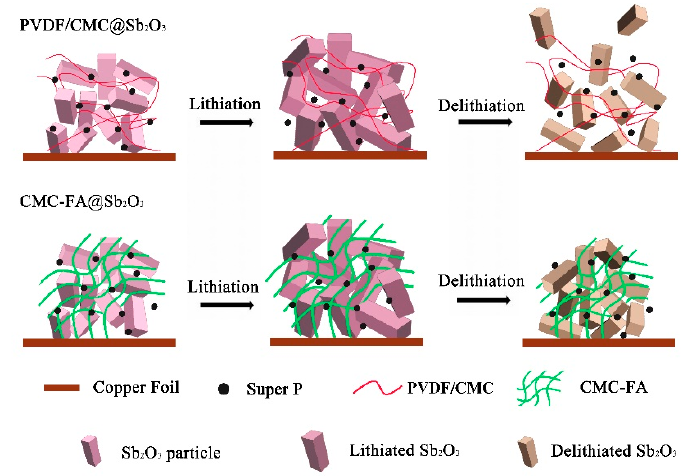
Figure 6. Schematic illustration of the proposed mechanism of cross-linked CMC-FA binder and PVDF / CMC binder in Sb 2 O 3 electrodes. Table 1. Comparison of the electrochemical performances of CMC-FA@Sb 2 O 3 with previously reported Sb 2 O 3 -based composites as anode materials for lithium ion